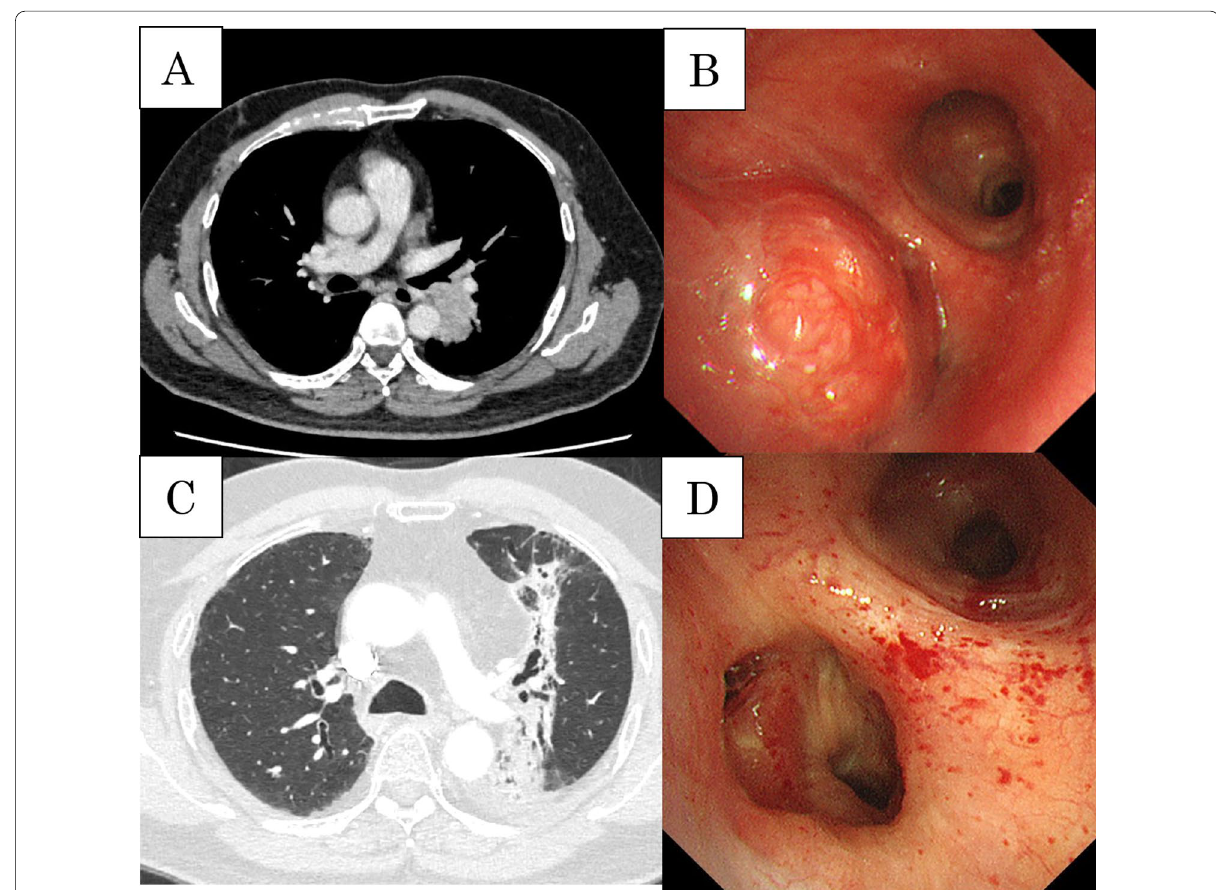
Fig. 1 Preoperative CT and bronchoscopic findings. A Initial CT showing squamous cancer in the left lower lung lobe. B The tumor protruding from the left lower bronchus and invading the left main bronchus. C CT showing moderate radiation pneumonitis after induction chemoradiation therapy. D Tumor regression after preoperative therapy shown by the appearance of the left lower